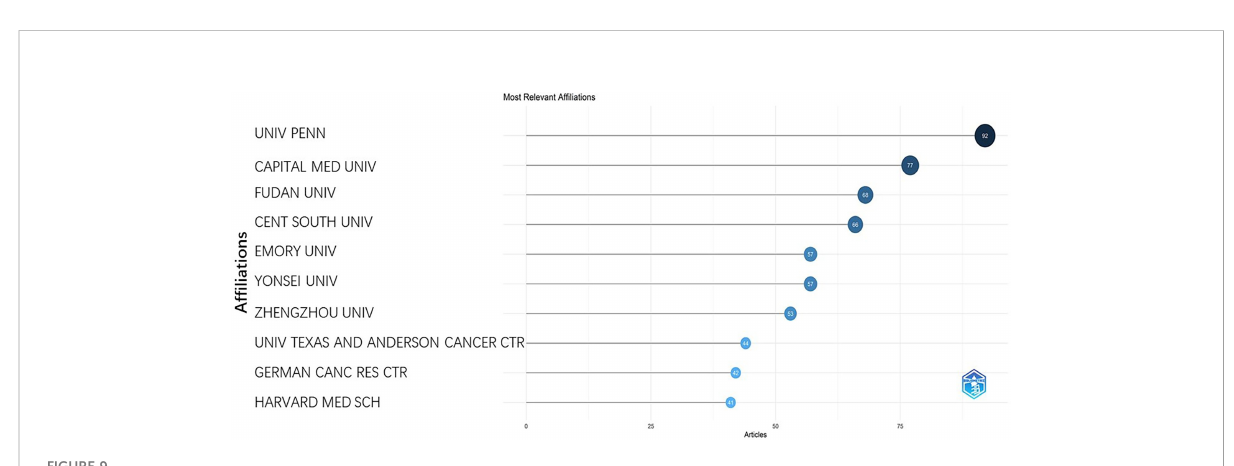
FIGURE 9 It represents the number of publications of different